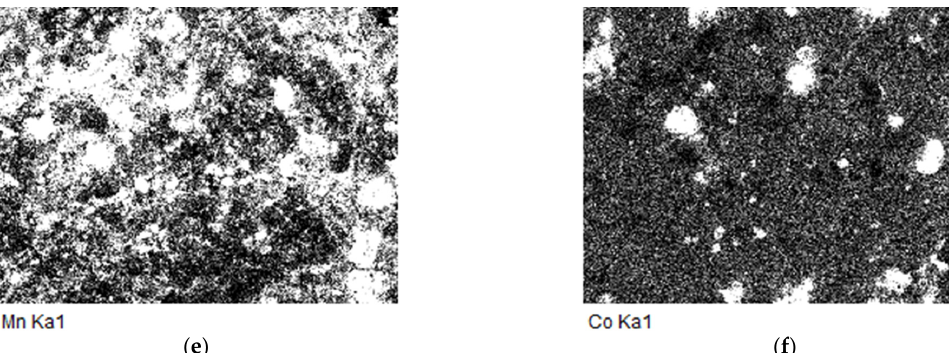
Figure 8. EDS analysis the fresh (Fe,Co,Mn)Ox material: ( a ) EDS spectrum; ( b ) electronic image of the (Fe,Co,Mn)Ox material; ( c ) EDS mapping of O; ( d ) EDS mapping of Fe; ( e ) EDS mapping of Mn; ( f ) EDS mapping of Co.